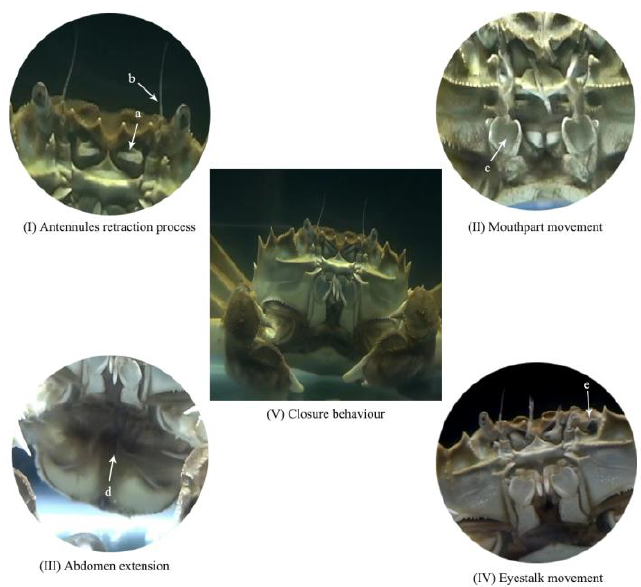
Figure 2. The main behaviors of Eriocheir sinensis in the experimental process (a: antennules; b: the second antennae; c: the third maxillipeds; d: abdomen; e: eyestalk).